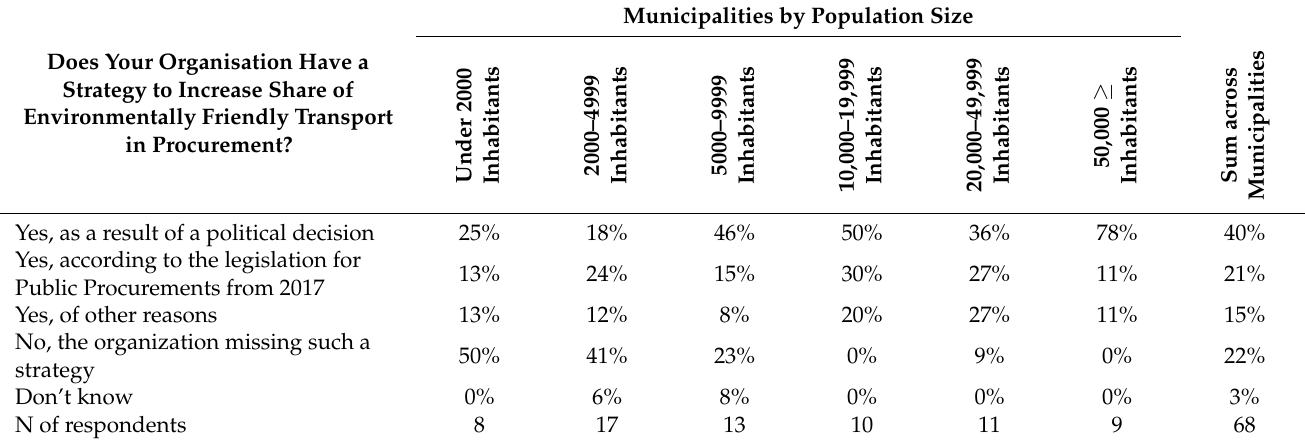
Table 6. Which municipalities has a strategy and